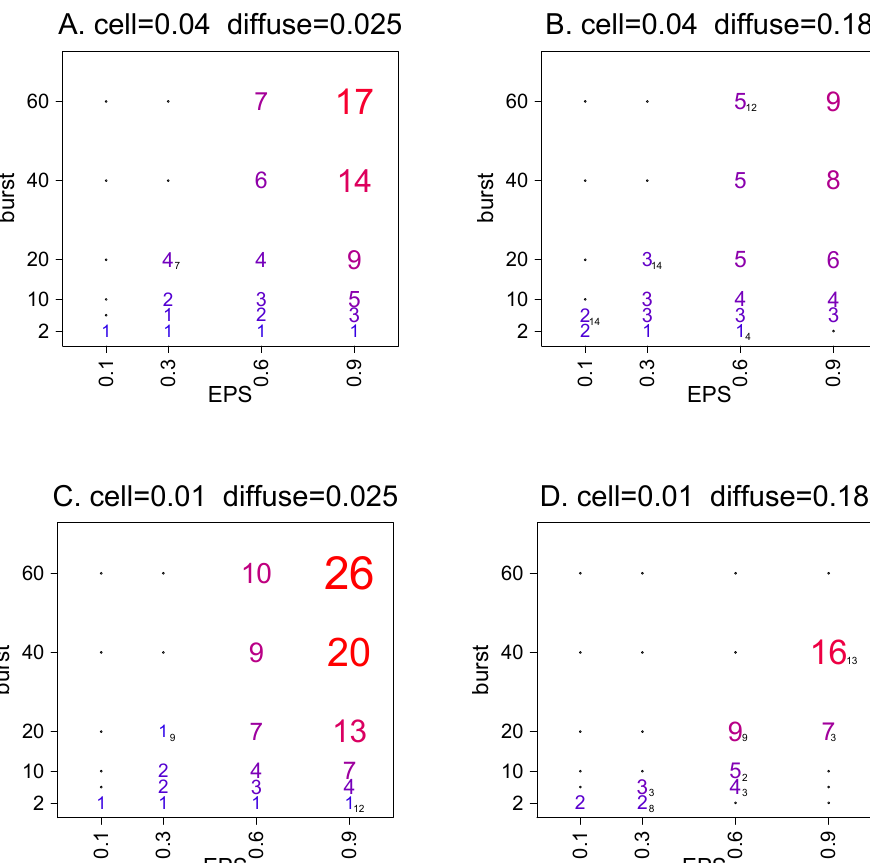
Figure 1. The density of cells maintained in the presence of phage is often increased by spatial structure. Shown in each panel are the A g values, giving the fold increase in cell density over that with mass action. A g values are greatly influenced by EPS levels and burst sizes, exceeding 10 only in the upper right quadrant, with large bursts and high EPS densities, and then only for some values of diffusion and cell reproduction rate. Values within each panel give average A g values from 15 trials each using the same burst and EPS levels, with rate of cell reproduction and phage diffusion rate given at the top of each panel; trials leading to extinction of phage or cells are not included in the averages. EPS was assigned randomly to each patch at the start and remained in the patch for the life of the run; superinfection of infected cells was not allowed ( k I = 0), nor was debris attachment ( k D = 0). Each trial ran 10,000 time steps, and A was averaged over the last 3000 steps; values are rounded to the nearest integer (values rounded to 1 were often less than 1). A black subscript denotes the number of trials with bacterial and/or phage extinction; a dot indicates that all 15 trials led to extinction. The ‘cell=’ value given above each panel is the probability that an uninfected cell reproduced at each time step; the ‘diffuse=’ value is the fraction of phage that left the patch in each time step. In all trials, the adsorption probability to uninfected cells was k C = 0.25, and that to EPS was k E =